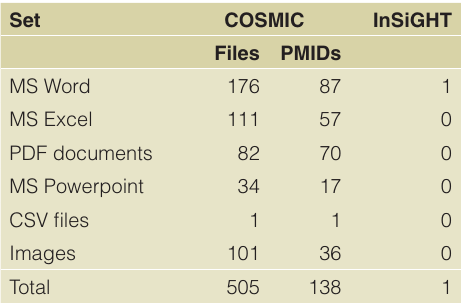
Table 2. Count of supplementary file types. Each row denotes one of file type. For each type, for COSMIC the number of files and the number of articles, denoted by PMIDs, is shown. In the case of the InSiGHT database, there is only one supplementary file in MS Word format linked to one